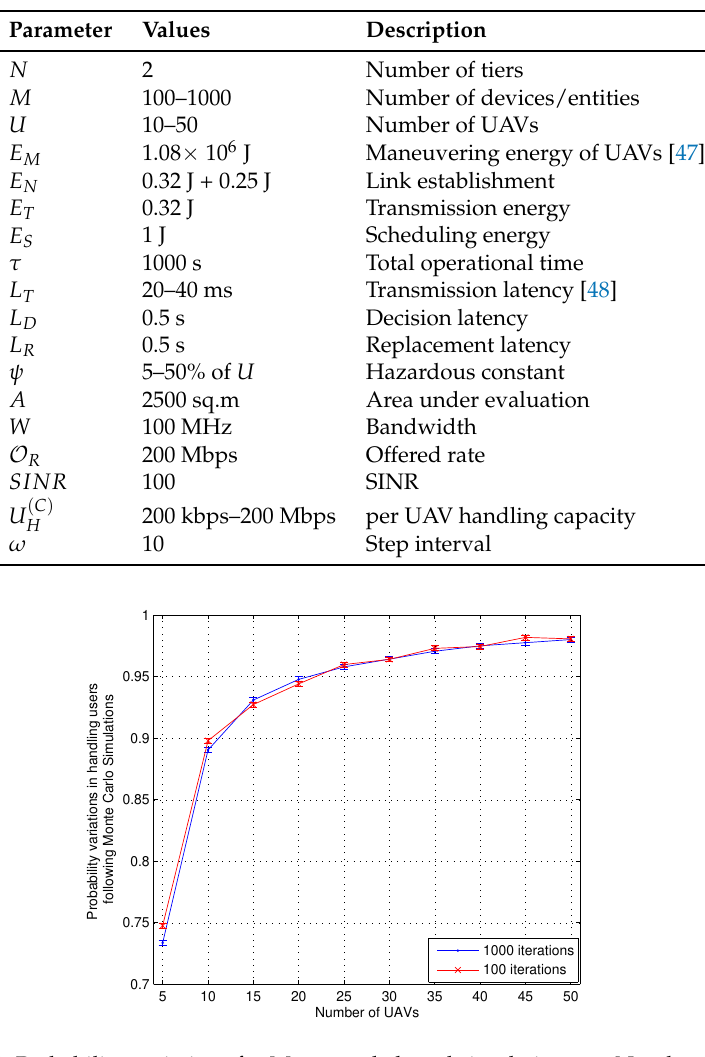
Table 2. Simulation parameters.